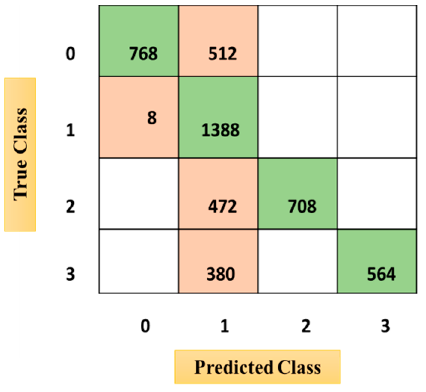
Figure 12. Confusion matrix for the ensemble RUSBoosted tree.